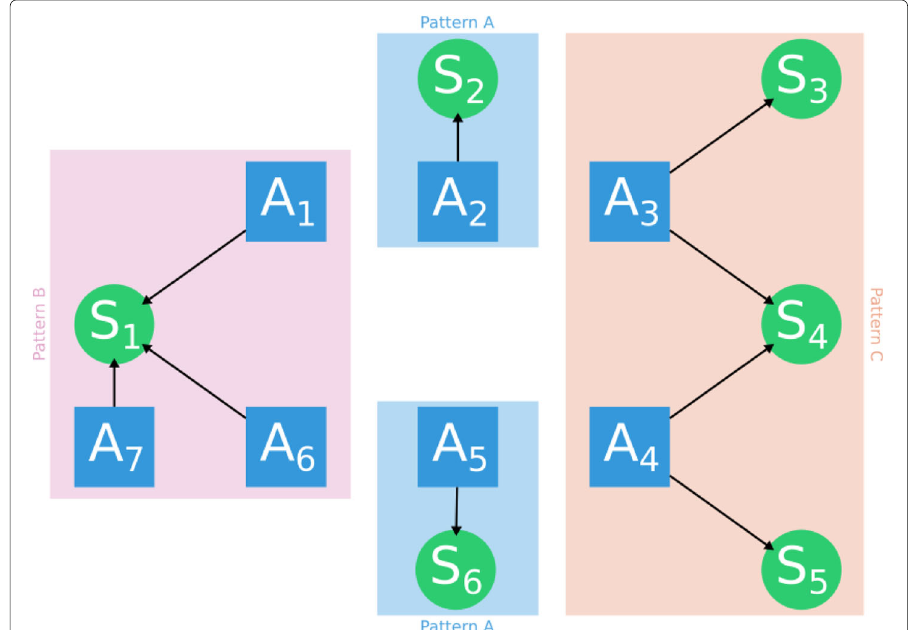
Fig. 4 Subgraphs (´patterns’) characterizing the transaction graph. Patterns are the connected subgraphs found when removing the node C from the graph. They represent suppliers and accounts found together in the set of